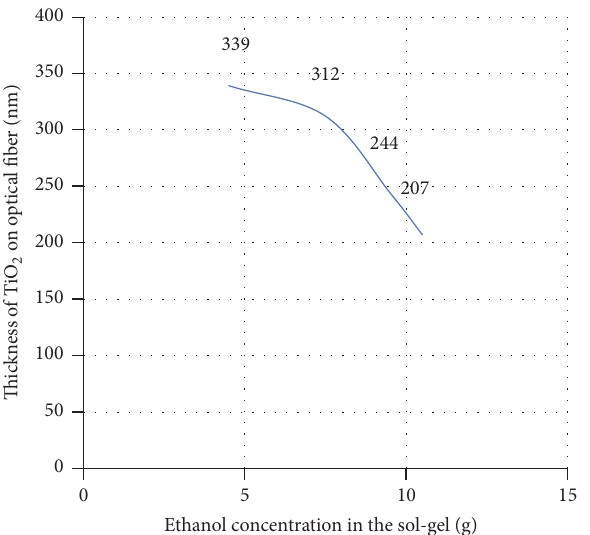
Figure 10: The relation between the different concentrations of ethanol in the sol-gel to the thickness of the TiO 2 on the optical fiber.